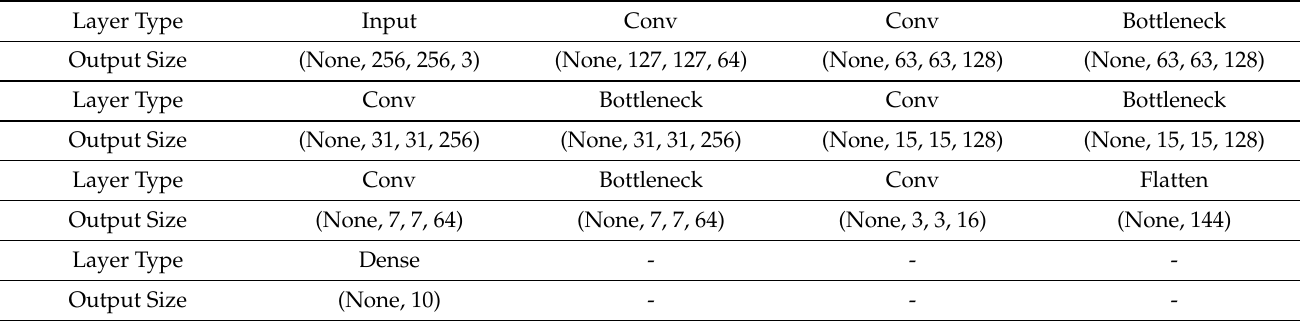
Table 5. Architecture details of the proposed CNN for hand gesture recognition. Note that each Conv layer represents 3 × 3 convolution, followed by ReLU activation along with batch normalization. The flow of the architecture is from left to right in each row (top to bottom for successive step). The details of the bottleneck are given in Table 4. Layer